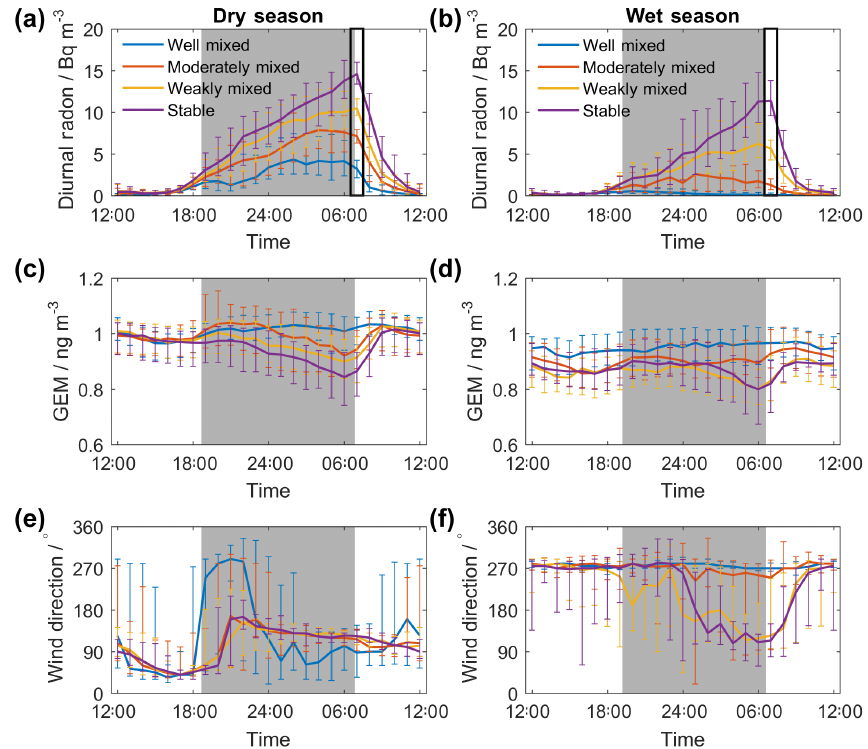
Figure 4. Diurnal composites of hourly radon ( a, b ), GEM ( c, d ), and wind direction ( e, f ) for (left) dry-season data and (right) all wet- season data. Edges of shading denote median sunset/sunrise times for each season. Data have been split into stability categories based on diurnal-component radon quartiles at sunrise (marked in top panels). Lines are median values, and error bars indicate inter-quartile